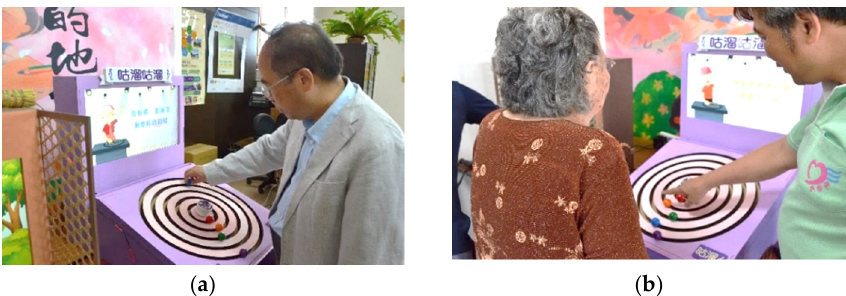
Figure 6. Scenes of the second field experiment. ( a ) A staff member of this study experiencing the operation of the interactive device. ( b ) A staff member of this study explaining the interaction process to a participating older